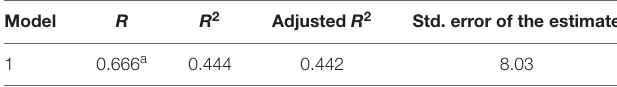
TABLE 5 | Model summary for teachers’ immunity, mindfulness, and engagement.